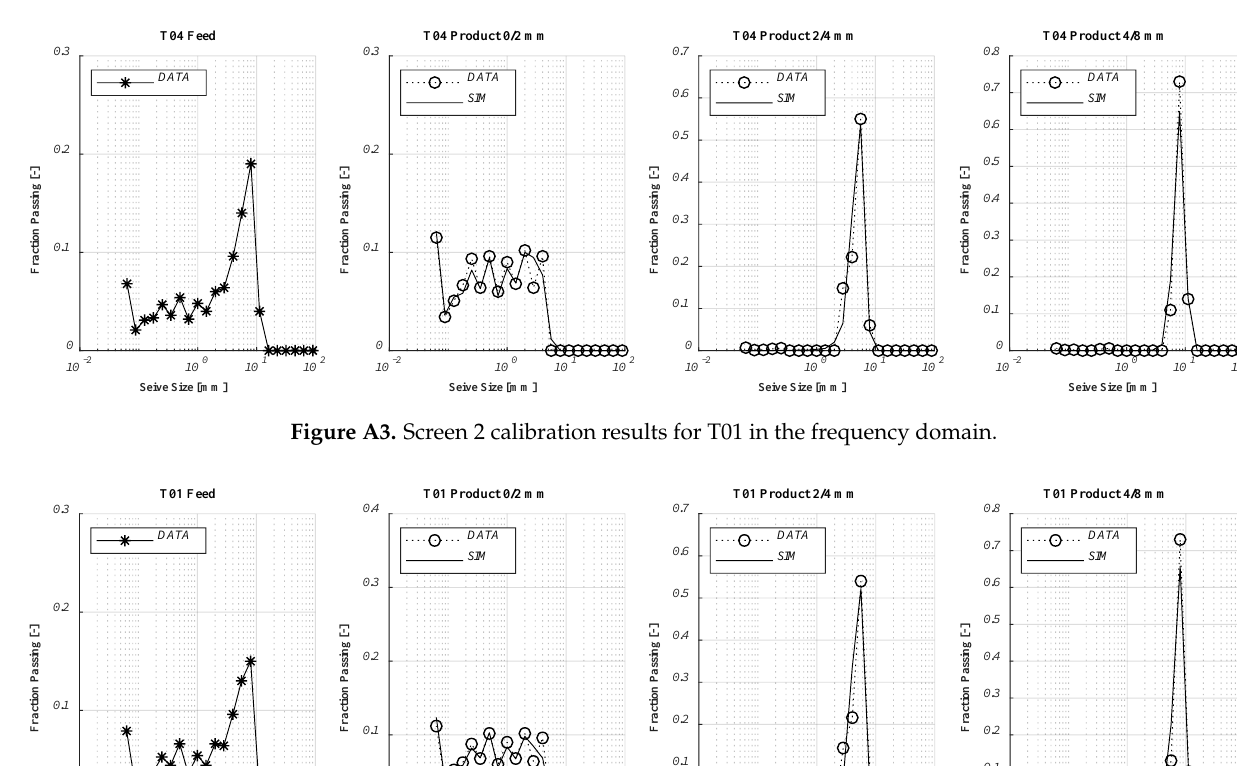
Figure A2. Screen 1 calibration results for T04 in the frequency domain.